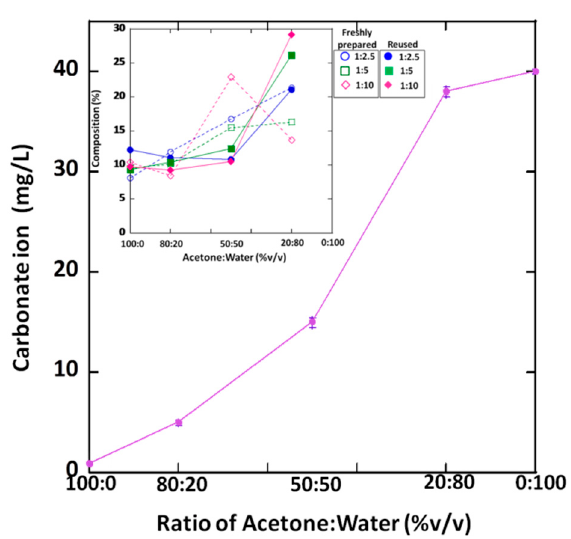
Figure 10. CaCO 3 concentration measured from the samples collected from the mixtures after being used for cenosphere separation using different acetone/water ratios and a fly ash/medium ratio of 1.5. The liquid samples were collected after a 4-h soaking period in the separation process.